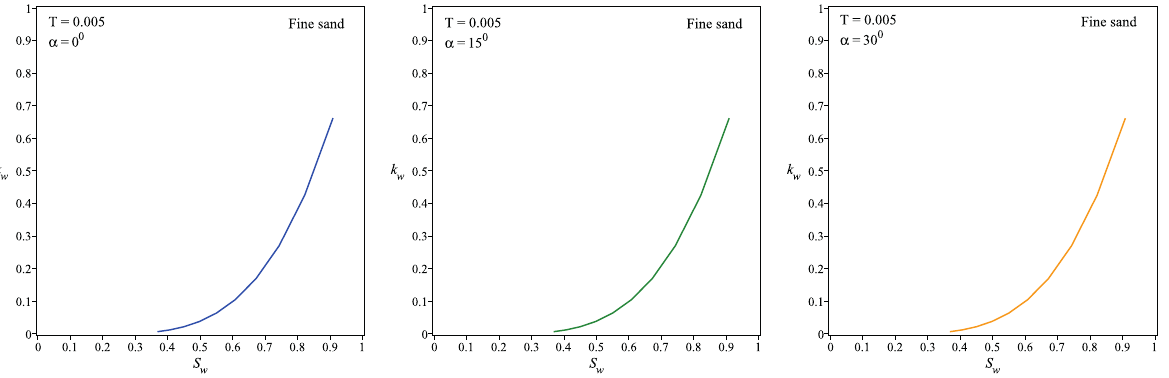
Fig. 9: Relative permeability vs. Saturation in Heterogeneous Porous Media for Fine Sand at different inclined plane α = 0 ◦ , 15 ◦ , 30 ◦ .